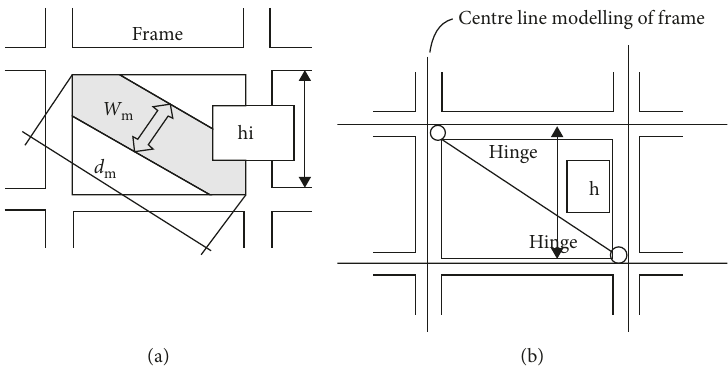
Figure 2: Brick infill panel as equivalent diagonal